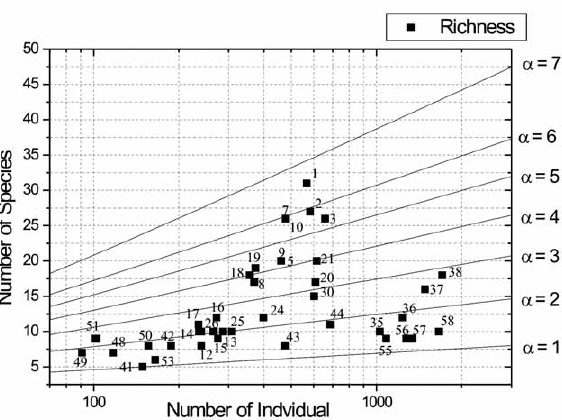
IG . 7. – Plot of the Fisher Index α calculated for the population of foraminifera.